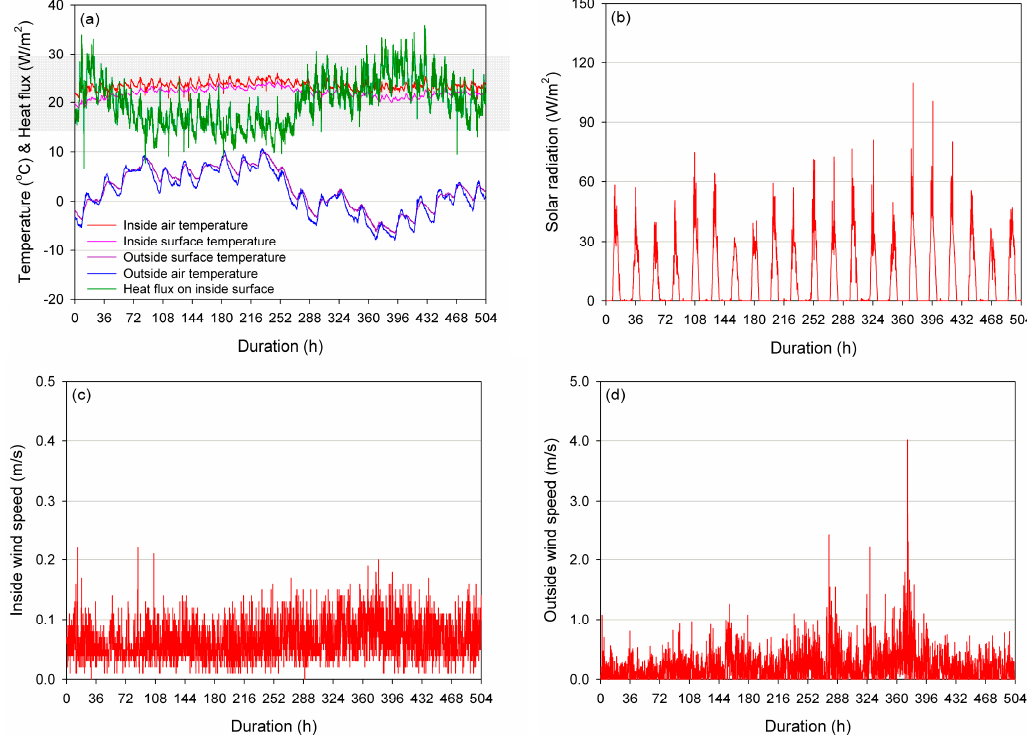
Figure 2. Data obtained from the monitoring process from December 30, 2016 to January 19, 2017: ( a ) Temperature and heat flux; ( b ) solar radiation; ( c ) inside wind speed; and ( d ) outside wind